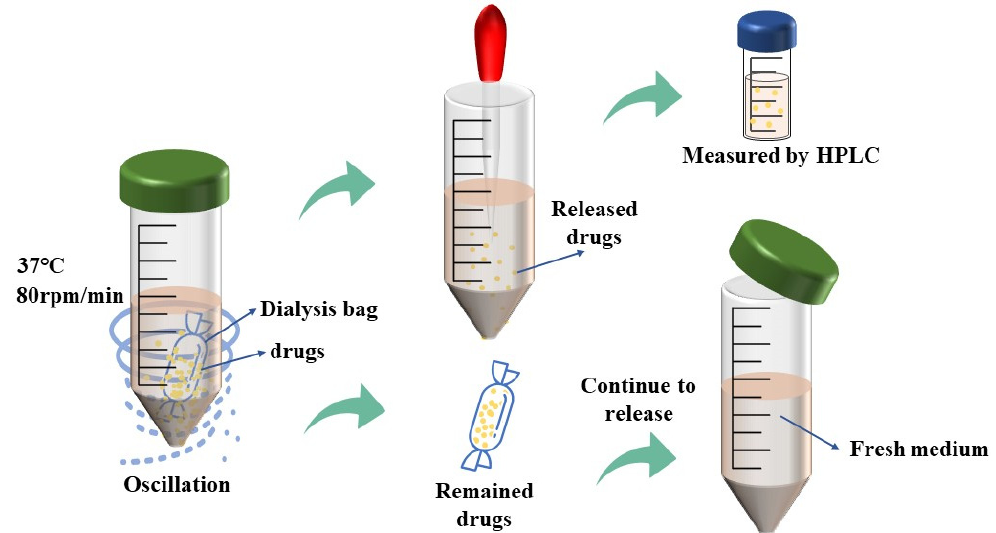
Figure 1. Schematic of a modified dialysis method for the timely removal of released